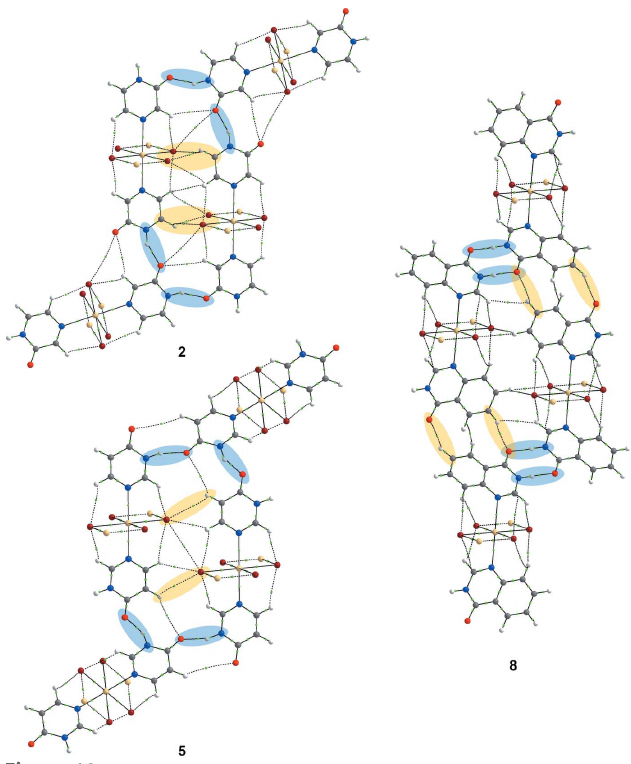
Figure 13 QTAIM analysis for a representative of each sub-class of complexes [CdBr 2 (2-pyz) 2 ] n ( 2 ), [CdBr 2 (4-pym) 2 ] n ( 5 ) and [CdBr 2 (4-quz) 2 ] n ( 8 ), showing the bond-critical points as green dots. Interactions between the best donors and best acceptors are marked with blue ovals, while interactions involving the second-best donors are marked with yellow ovals. QTAIM analysis results for all the complexes can be found in the supporting information (Figs.